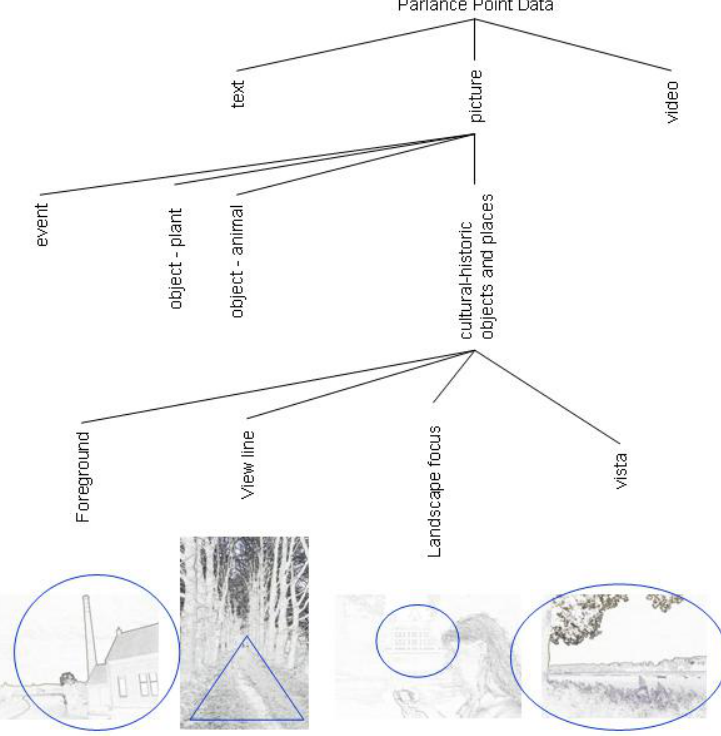
Figure 4. Three levels of PP classification. The pictures on the third level show the four framing